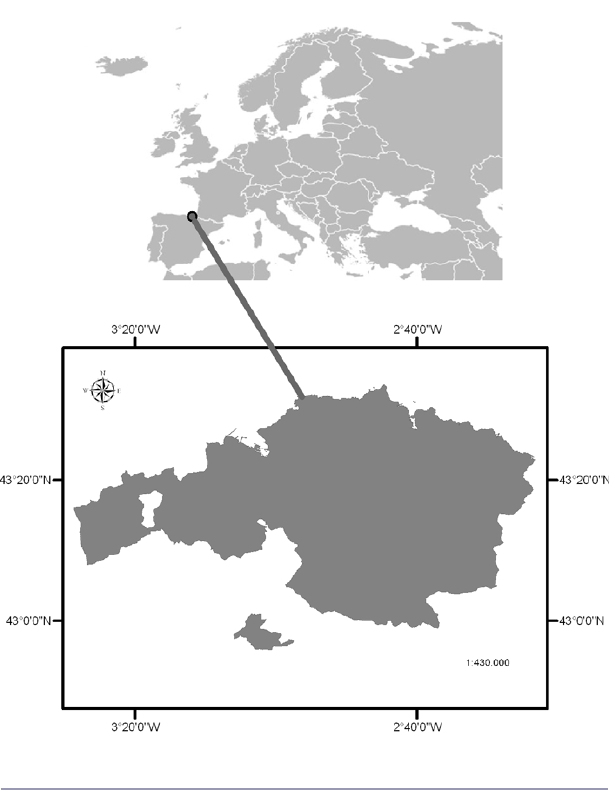
Fig. 1 . Map of the study area: Biscay in relation to